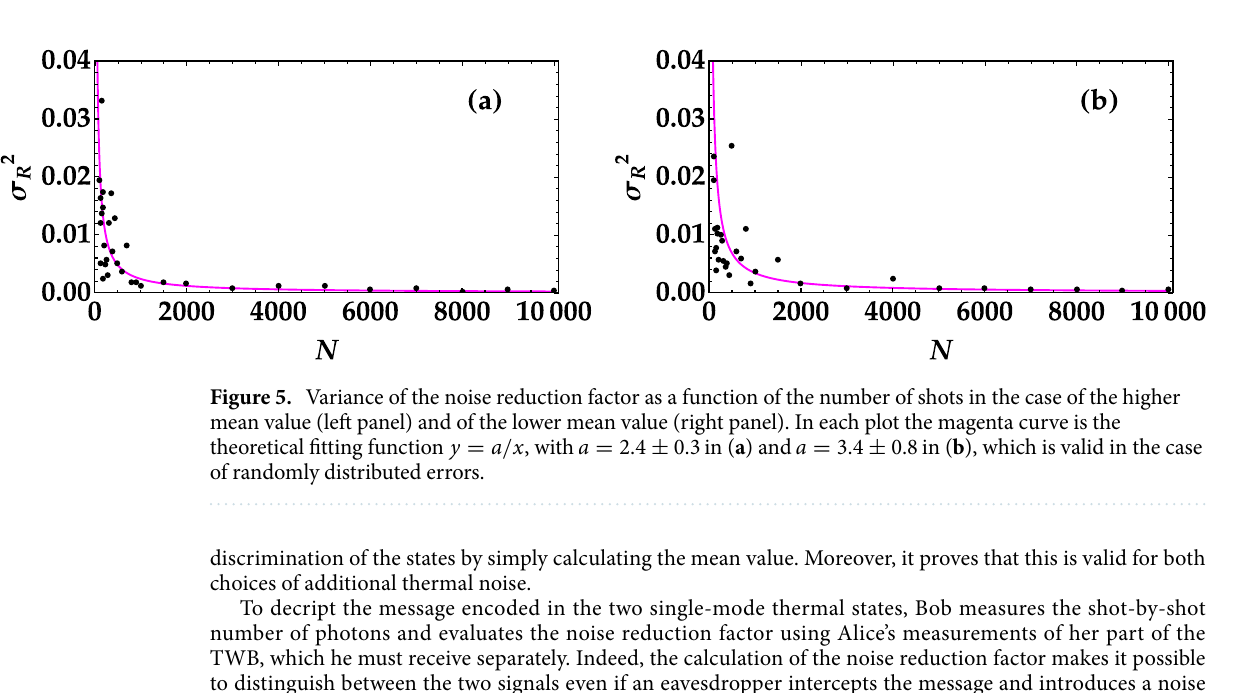
Figure 4. Difference between the mean number of detected photons calculated over N shots and that corresponding to 100,000 shots as a function of the number of shots in the case of the higher mean value (black dots) and of the lower mean value (red dots).